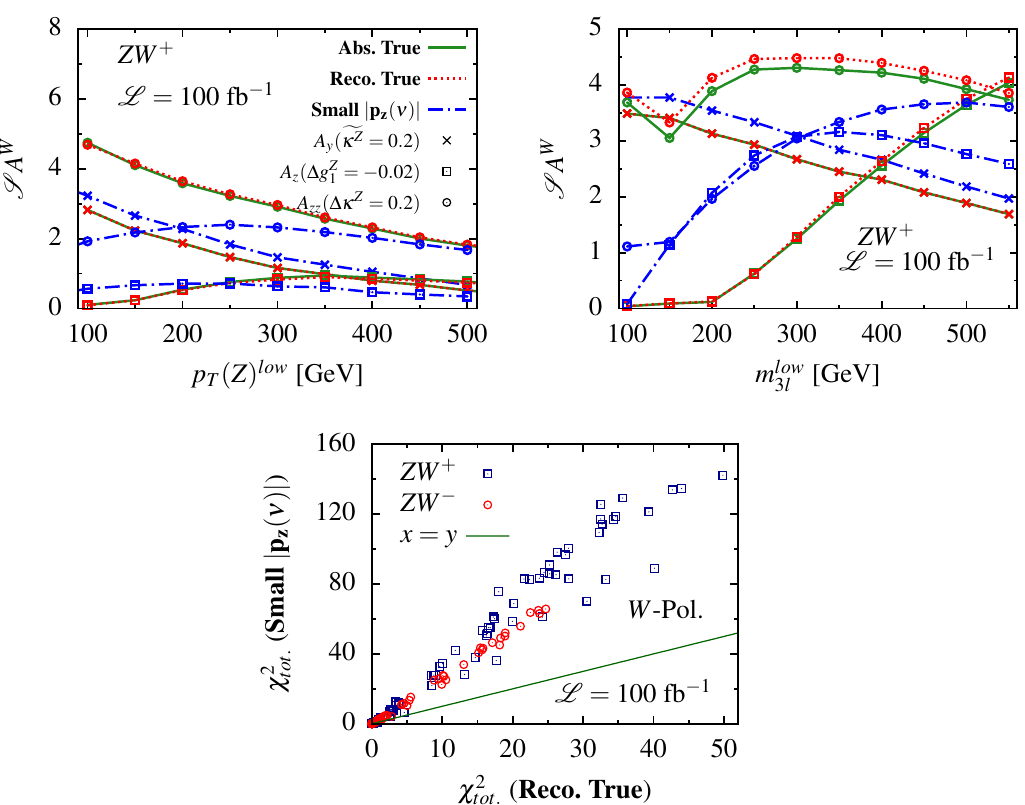
Figure 6 . The sensitivity of some polarization asymmetries of W + ( ZW + ) on some benchmark aTGC for three scenarios: with absolute truth ( Abs. True ) information of neutrino in solid /blue lines, with the close to true reconstructed solution of neutrino ( Reco. True ) in dotted /red lines p z ( (cid:23) ) and with the smaller p z ( (cid:23) ) to be the true solution ( Small ) in dash-dotted /blue lines as a j j j j function of the lower cut on p T ( Z ) ( top-left-panel ) and m 3 l ( top-right-panel ) at p s = 13 TeV and L = 100 fb (cid:0) 1 . The scatter plot of the total (cid:31) 2 for about 100 aTGC points using all the asymmetries p z ( (cid:23) ) of W (cid:6) for Reco. True in x -axis with Small in y -axis is shown in the bottom-panel j j